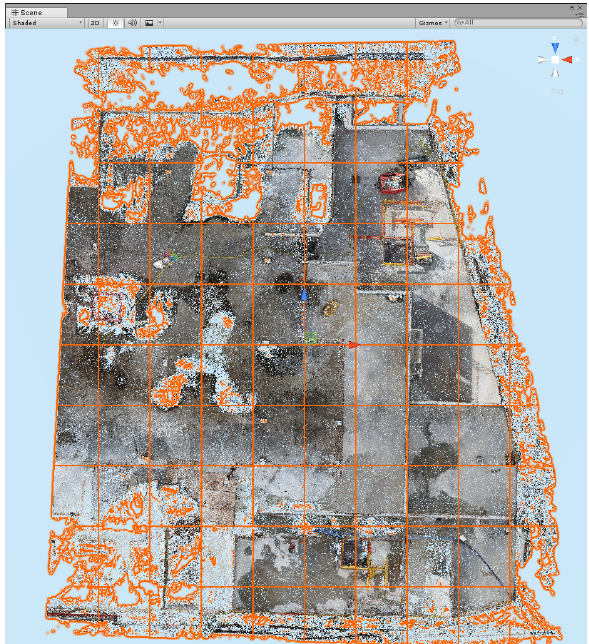
Figure 5: By splitting the point cloud data into multiple parts, the game’s frame rate can be increased substantially because only the point cloud parts in the field of view of the user should be